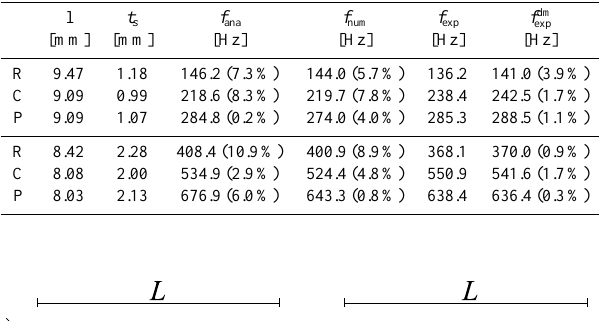
Table 5. Natural frequencies for rectangular ( R ), circular ( C ) and parabolic ( P ) flexure hinges connected to a rigid body ( H = 10 mm , L = 50 mm , b = 10 mm )